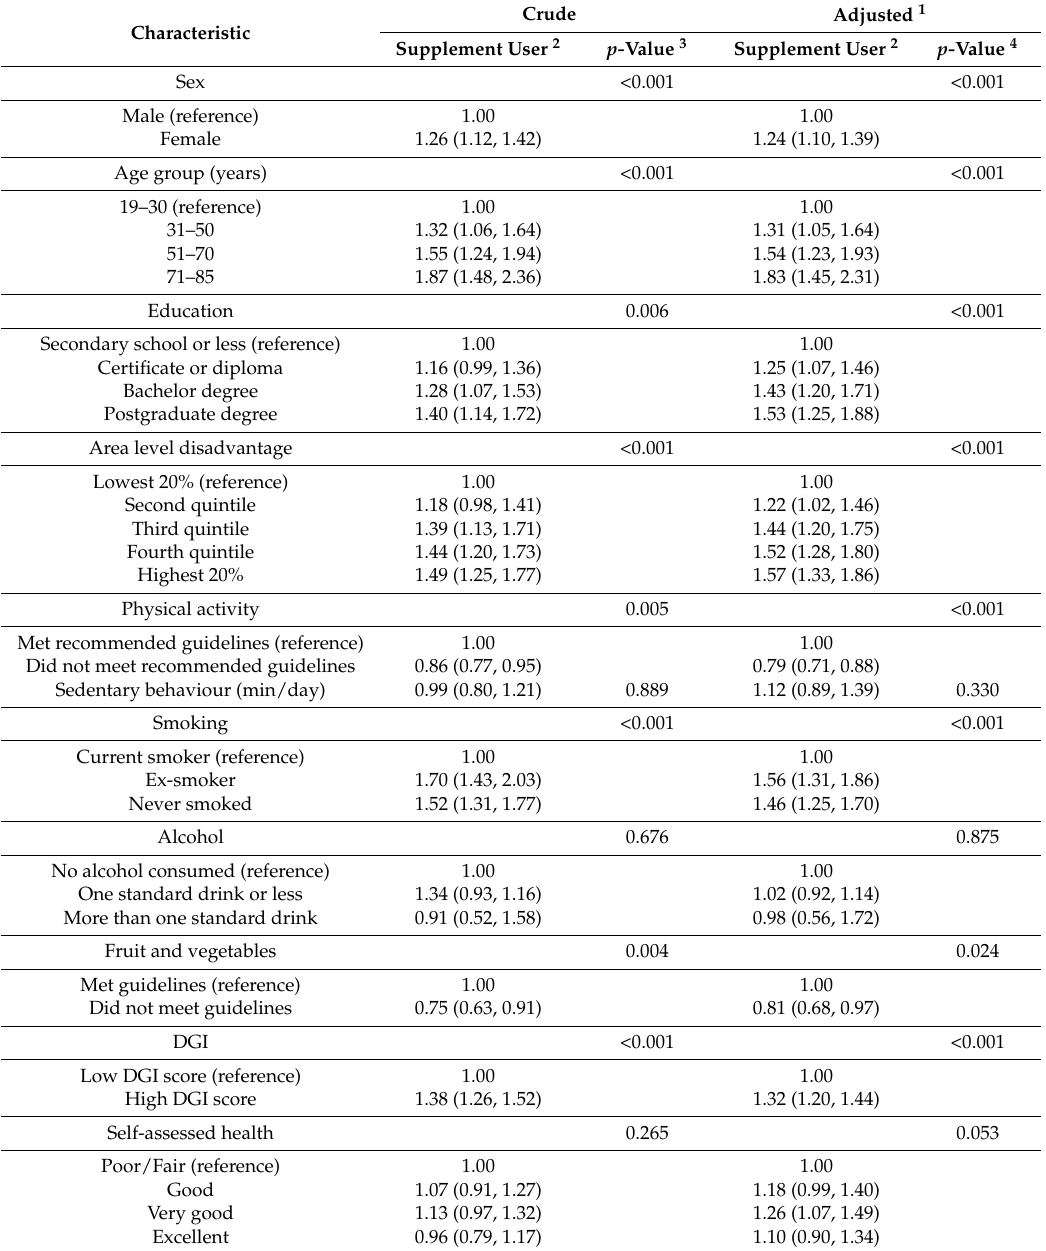
Table 2. Dietary supplement use (prevalence ratio and 95% confidence intervals) across demographic and lifestyle characteristics in adults from the Australian Health Survey ( n =